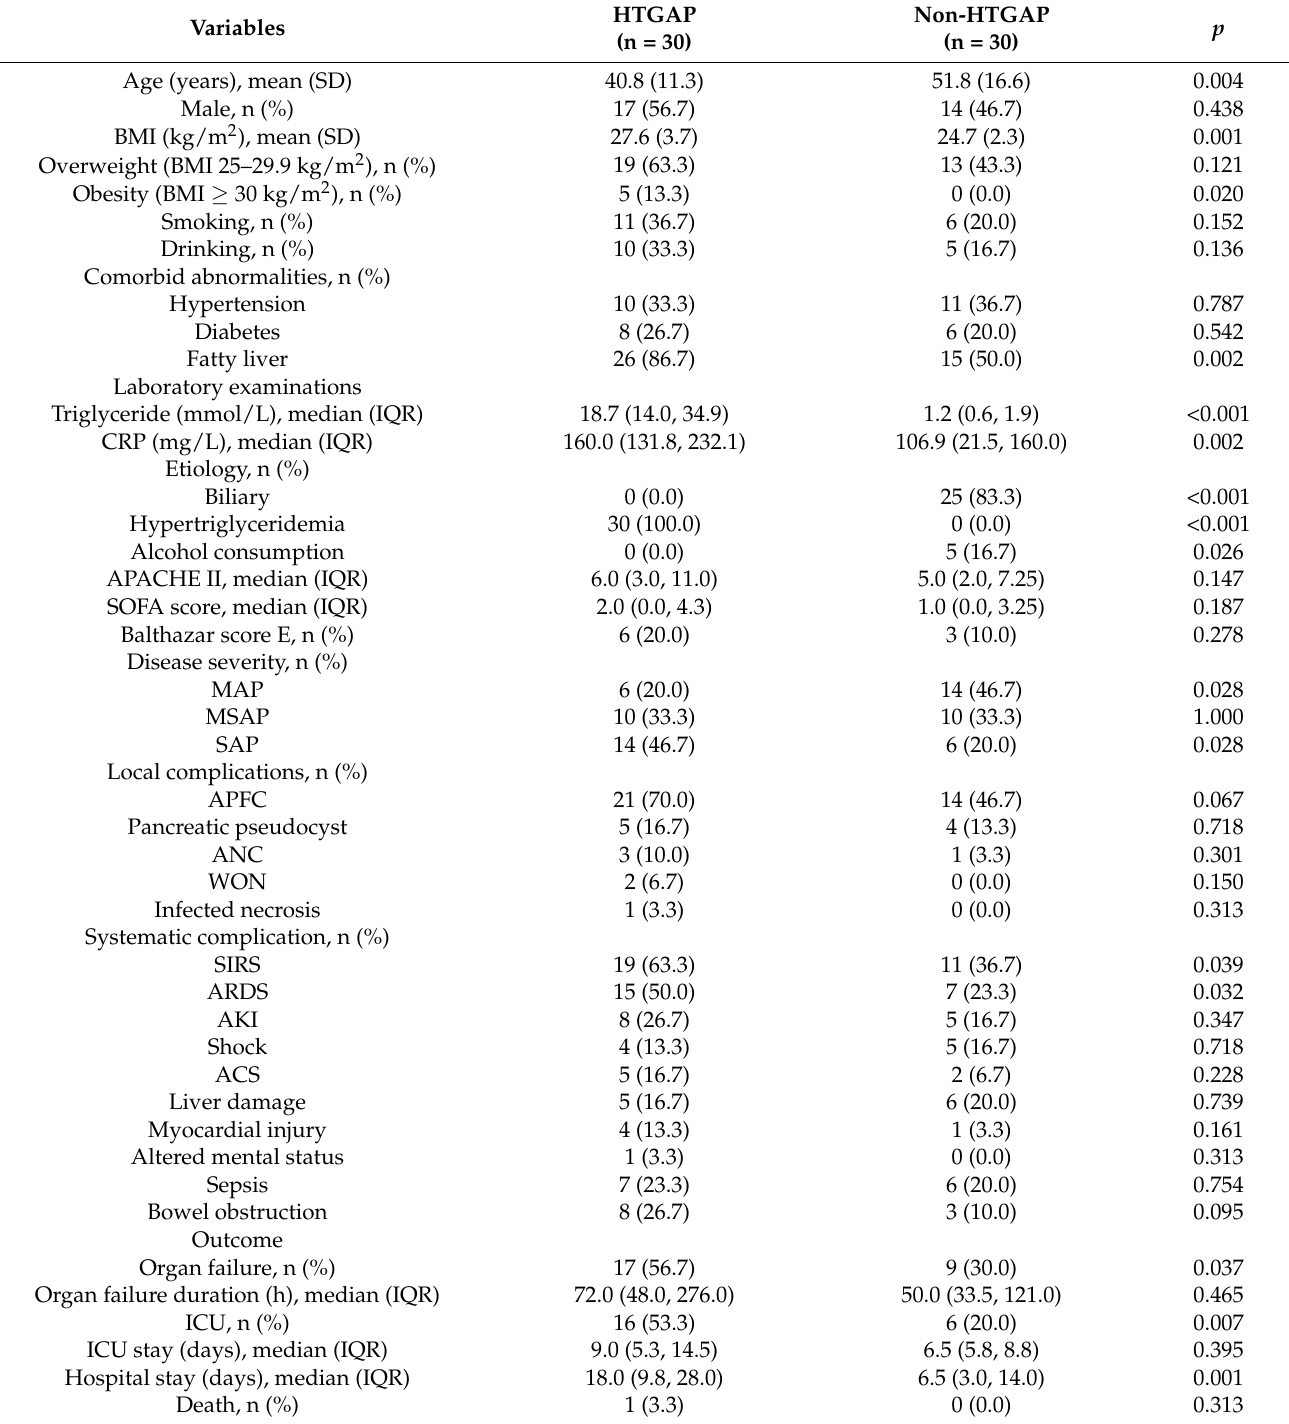
Table 1. Demographic and clinical characteristics of two